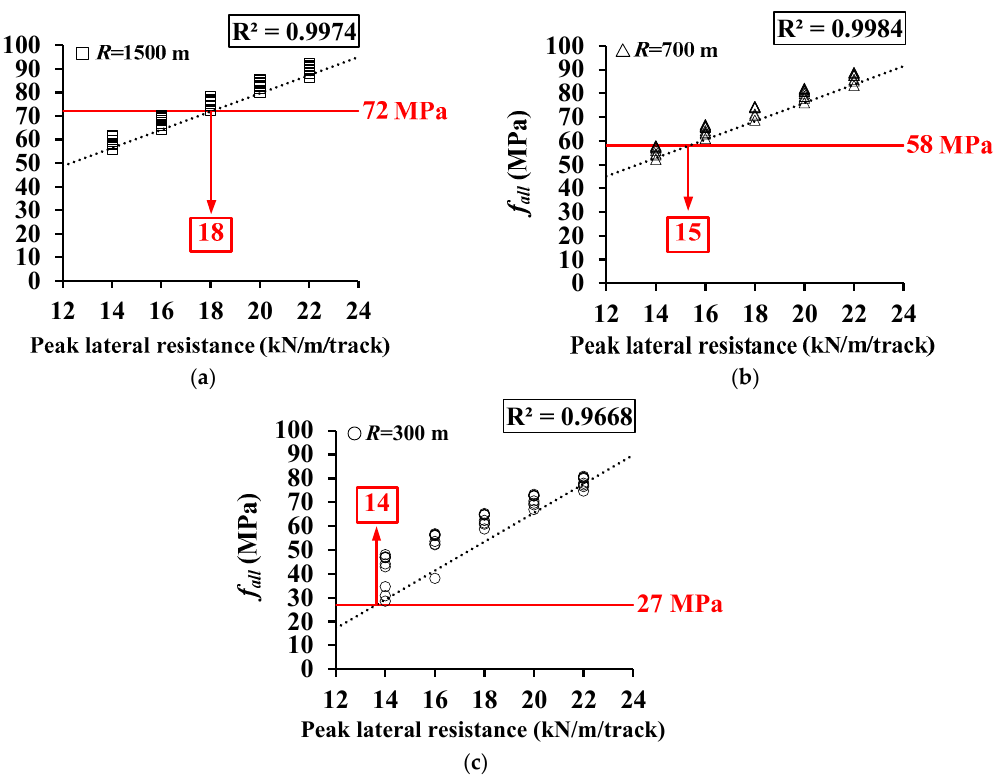
Figure 16. f all vs. P.L.R.: ( a ) R = 1500 m; ( b ) R = 700 m; and ( c ) R = 300 m.